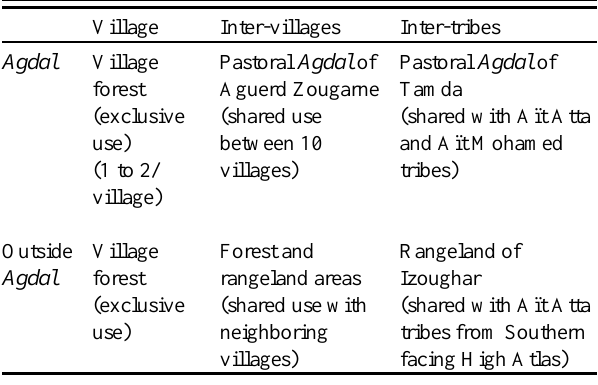
segmentary level control of the main resource spaces in the Aït Bouguemmez valley